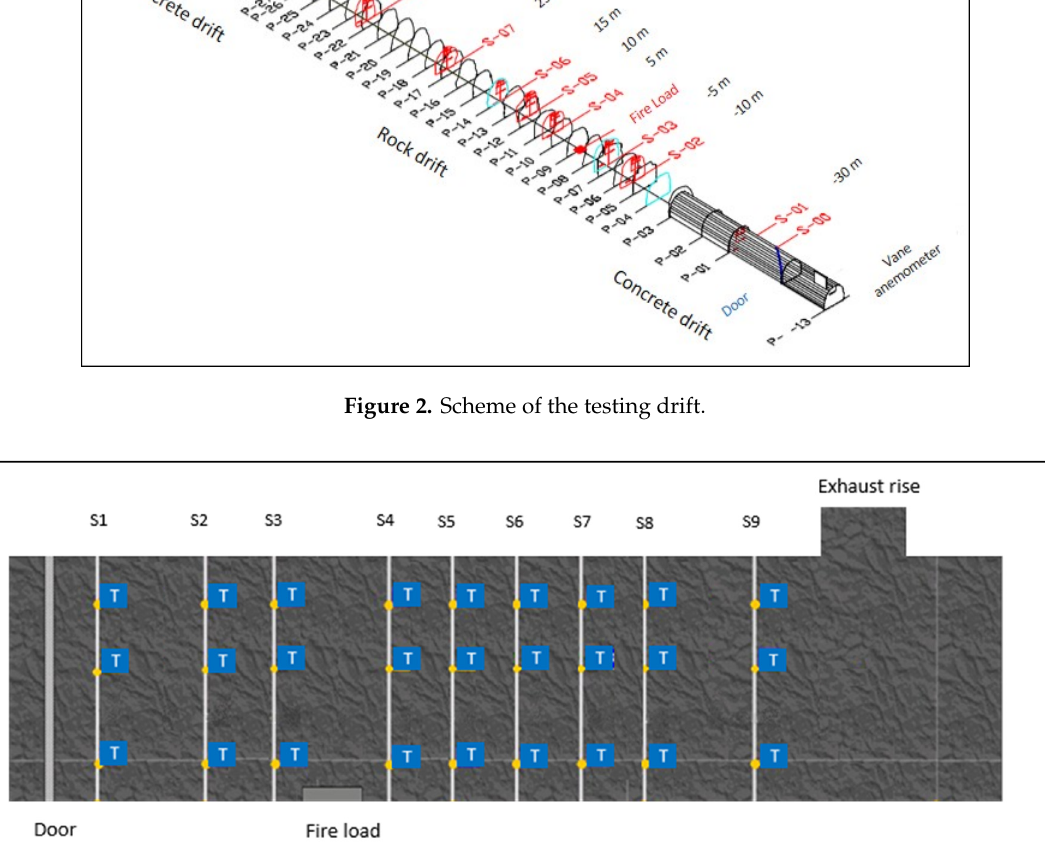
Figure 3. Section of the testing drift with the sensors, T, at different heights. Table 1. Characteristics of the sensors.